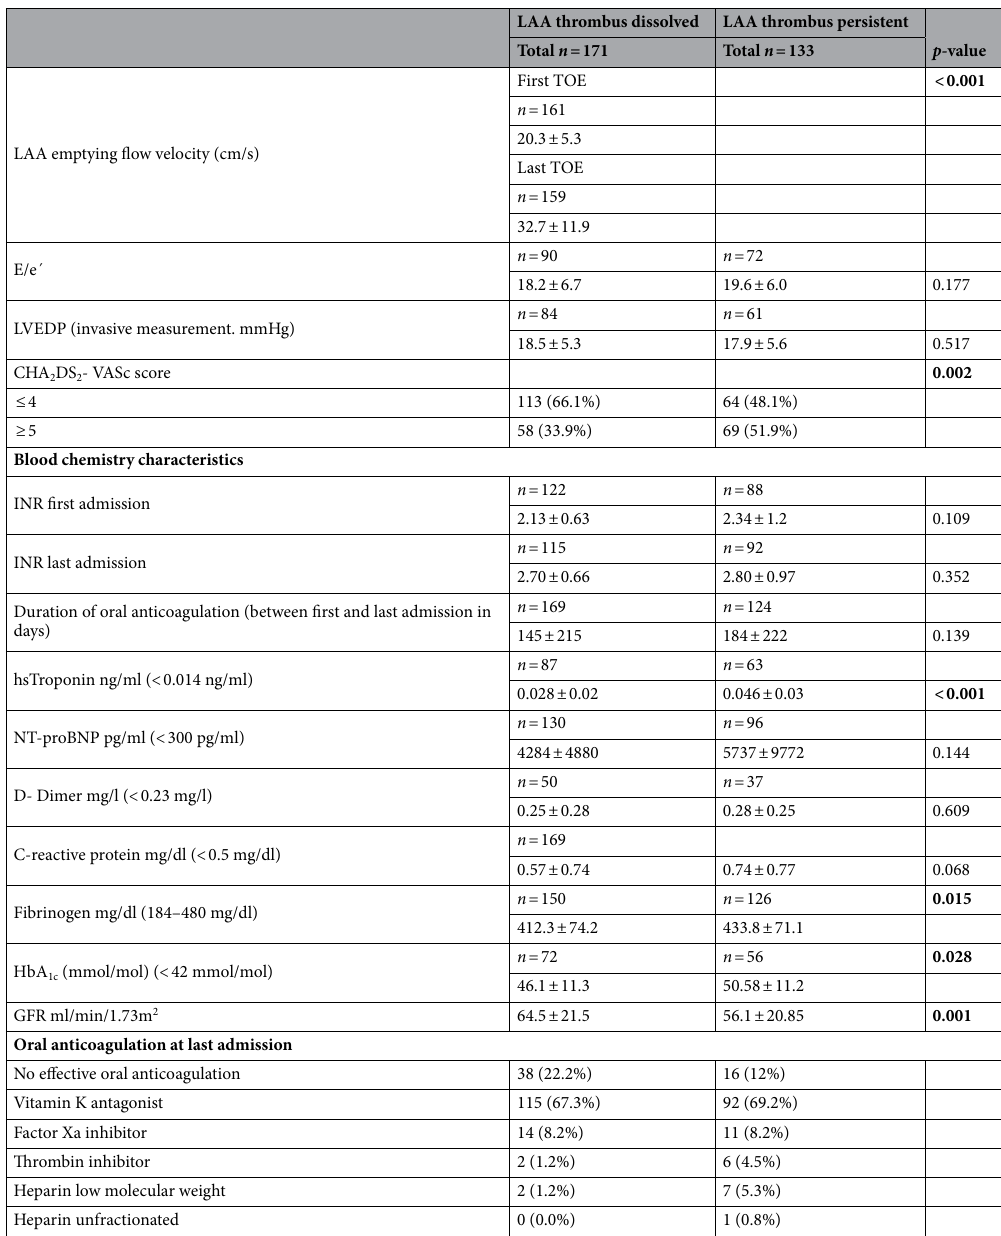
Table 2. Baseline characteristics of patients with dissolved and persistent LAA thrombi. Data are displayed as n (%) or mean ± SD. Actual numbers of patients differing from total number of study group are indicated separately for each parameter. Significant values are in